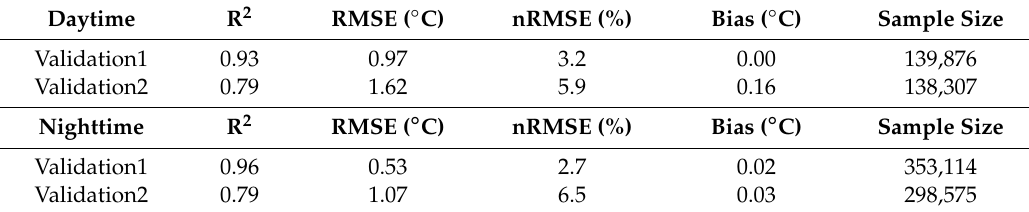
Table 2. The two validation results of the 1 km LST estimation from scheme 2(S2) for daytime and